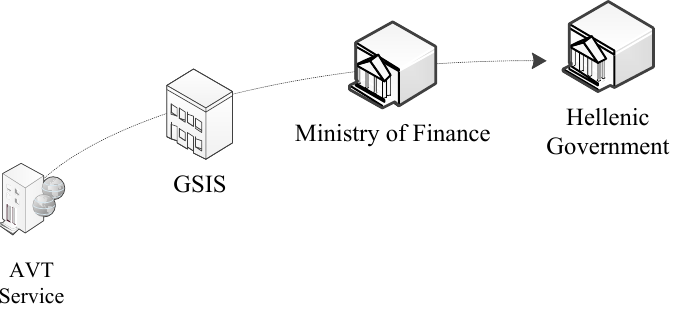
Figure 3. Case Study Privacy Policies